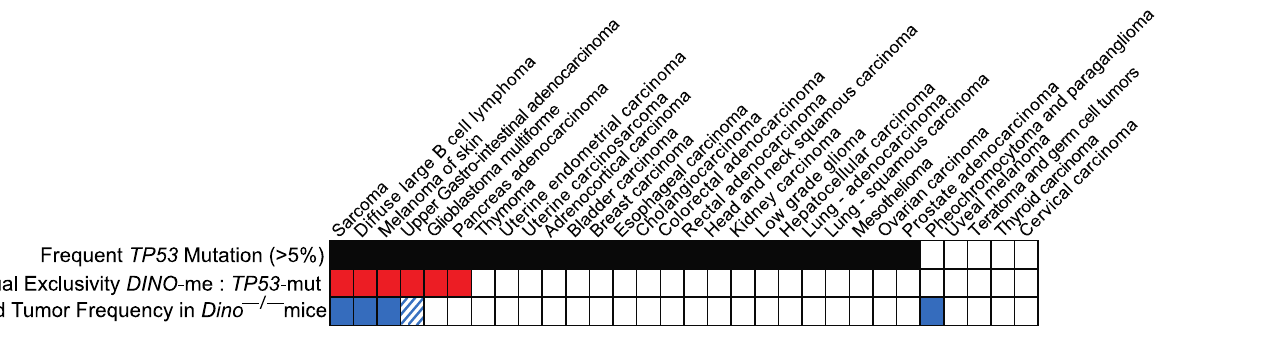
Figure 2. The spectrum of spontaneous tumors in Dino − / − mice reflects the spectrum of human cancers in which TP53 mutations and DINO hypermethylation are mutually exclusive. Analysis of 30 human tumor types in the TCGA dataset identifies a subset of six tumor types in which TP53 mutations are mutually exclusive with DINO hypermethylation (red). Dino − / − mice spontaneously developed tumors in 3 of these tumor classifications including sarcoma, diffuse large B cell lymphoma and melanoma of the skin (blue). DINO hypermethylation and TP53 mutations are mutually exclusive in stomach adenocarcinoma, an upper gastrointestinal malignancy, and another upper gastrointestinal adenocarcinoma arising from the jejunum was observed in a Dino − / − mouse (blue stripes). Fisher’s exact test for an interaction; p = 0.001.